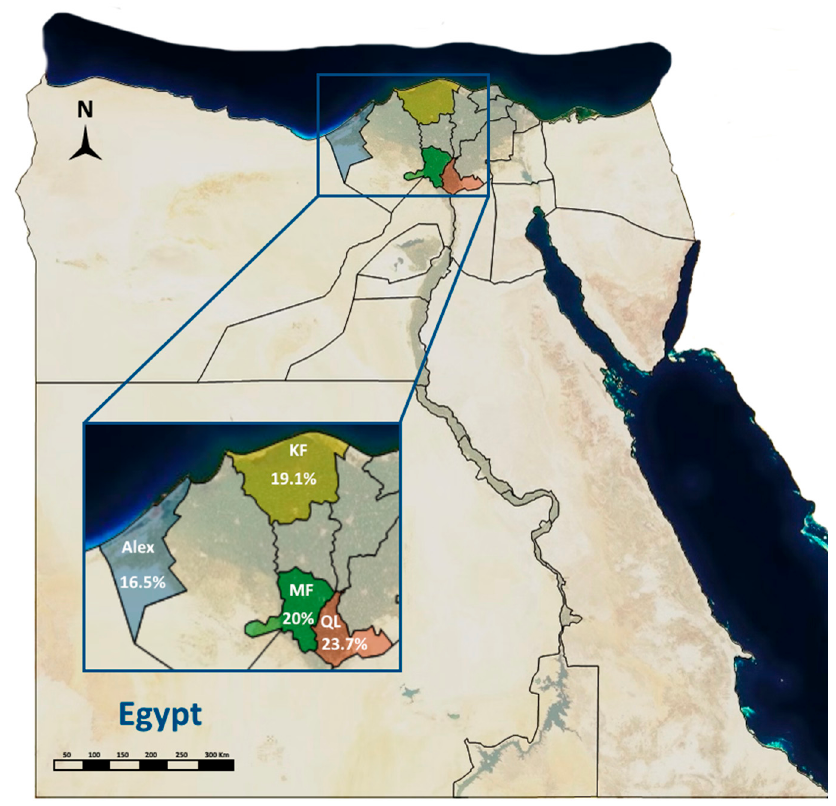
Figure 1. Geographic distribution of contagious caprine pleuropneumonia in sheep and goats of the Nile Delta of Egypt.